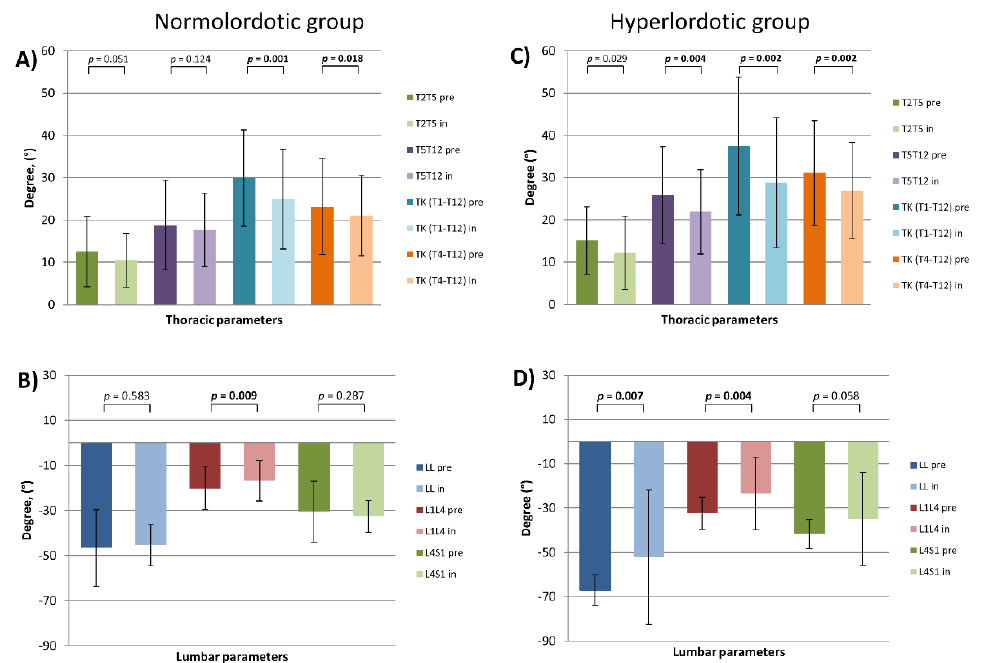
Figure 6. Sagittal thoracic and lumbar parameters by lumbar lordosis (LL) stratified patients (pre- and in-brace). ( A ) thoracic and ( B ) lumbar parameters of the normolordotic group. ( C ) thoracic and ( D ) lumbar parameters of the hyperlordotic group; p = statistical significance, p < 0.05.